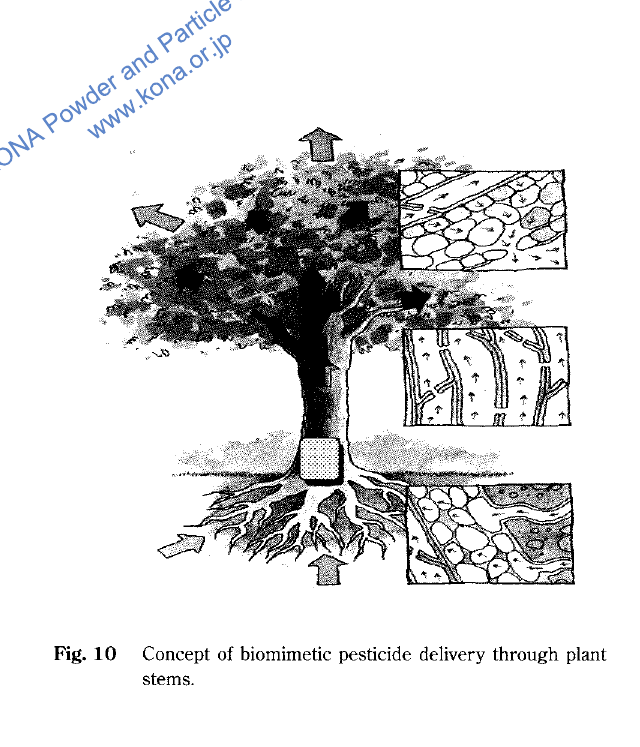
Concept of biomimetic pesticide delivery through plant stems.